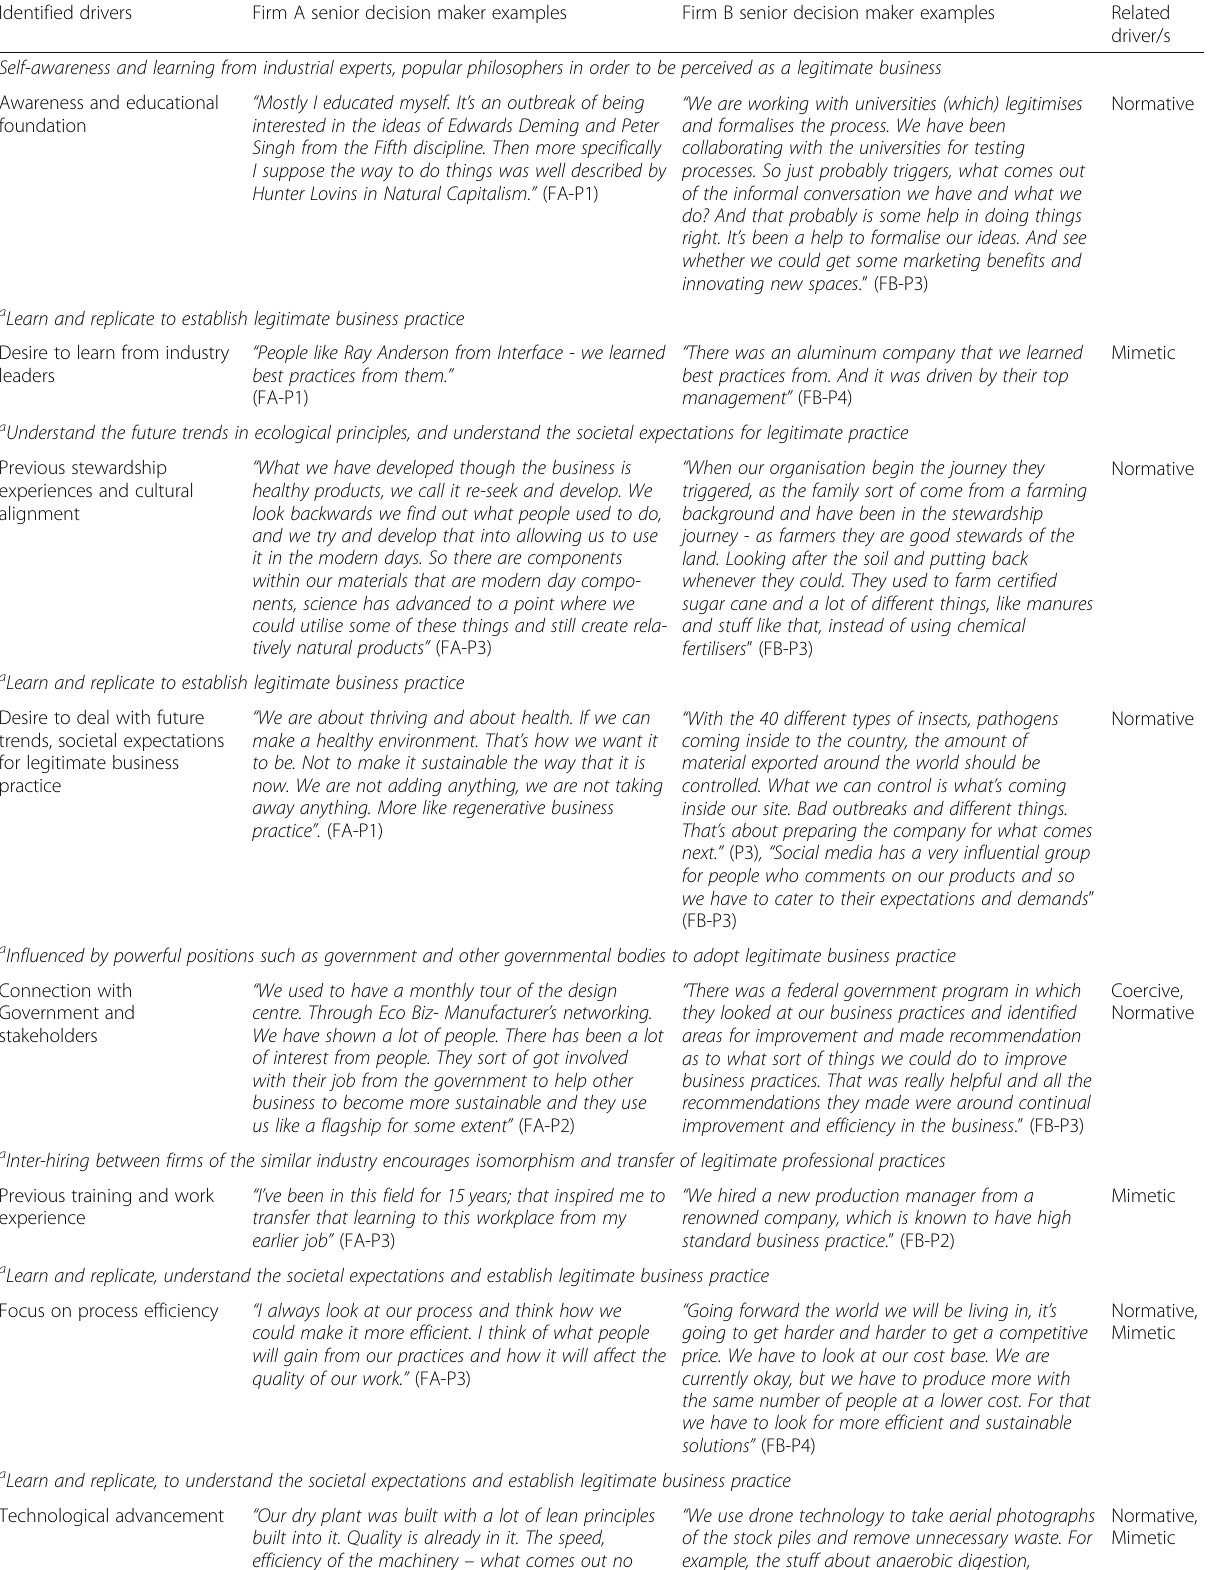
Table 3 Identified drivers and examples of sustainable business practice Identified